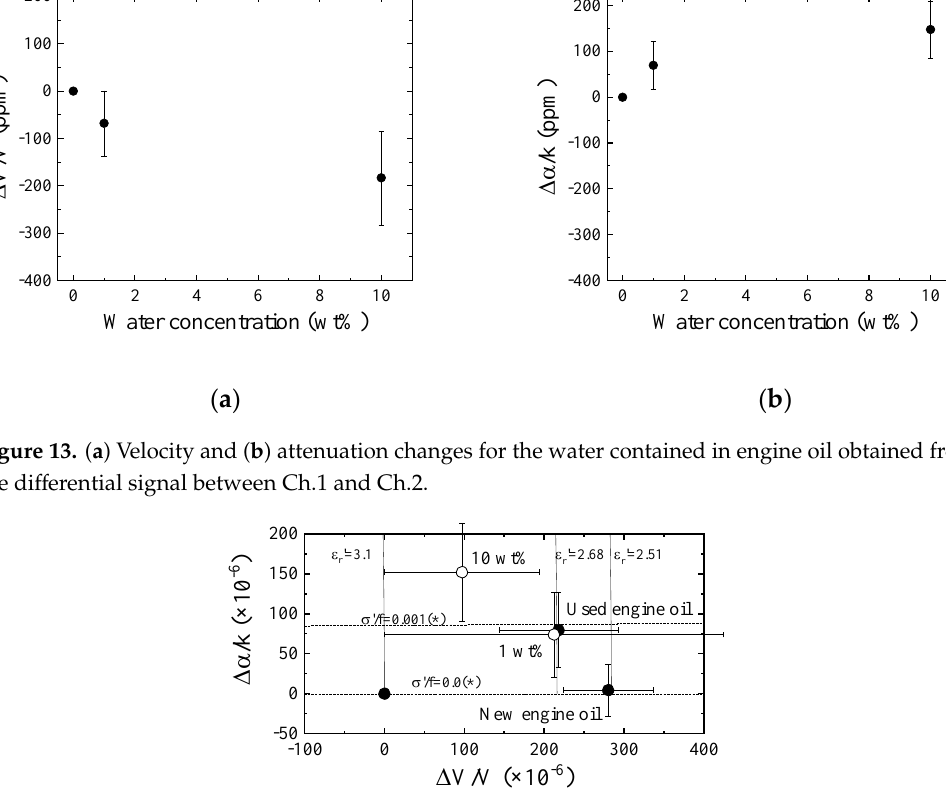
Figure 14. Evaluation of the SH-SAW sensor responses in Figure 13 using the relative permittivity– conductivity chart. The results of the olive oil and new and used engine oils are also plotted in the figure. (*: 1 × 10 − 8 (S/m)/Hz)